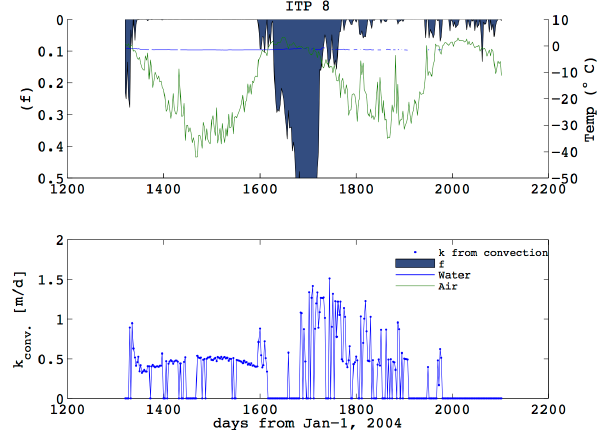
1 Figure 8. Top panel: Surface air and water temperature and fraction of open water along the ITP 2 Fig. 8. (top) Surface air and water temperature and fraction of open 8 drift track. Bottom panel: Gas transfer velocity ( k conv. ) resulting from heat flux-driven 3 water along the ITP 8 drift track. (bottom) Gas transfer velocity convection in the IOBL. 4 ( k conv ) resulting from heat flux-driven convection in the IOBL. 5